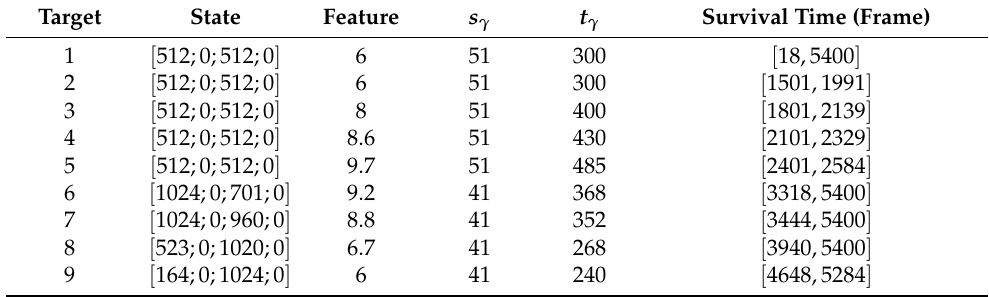
Table 5. The target initial